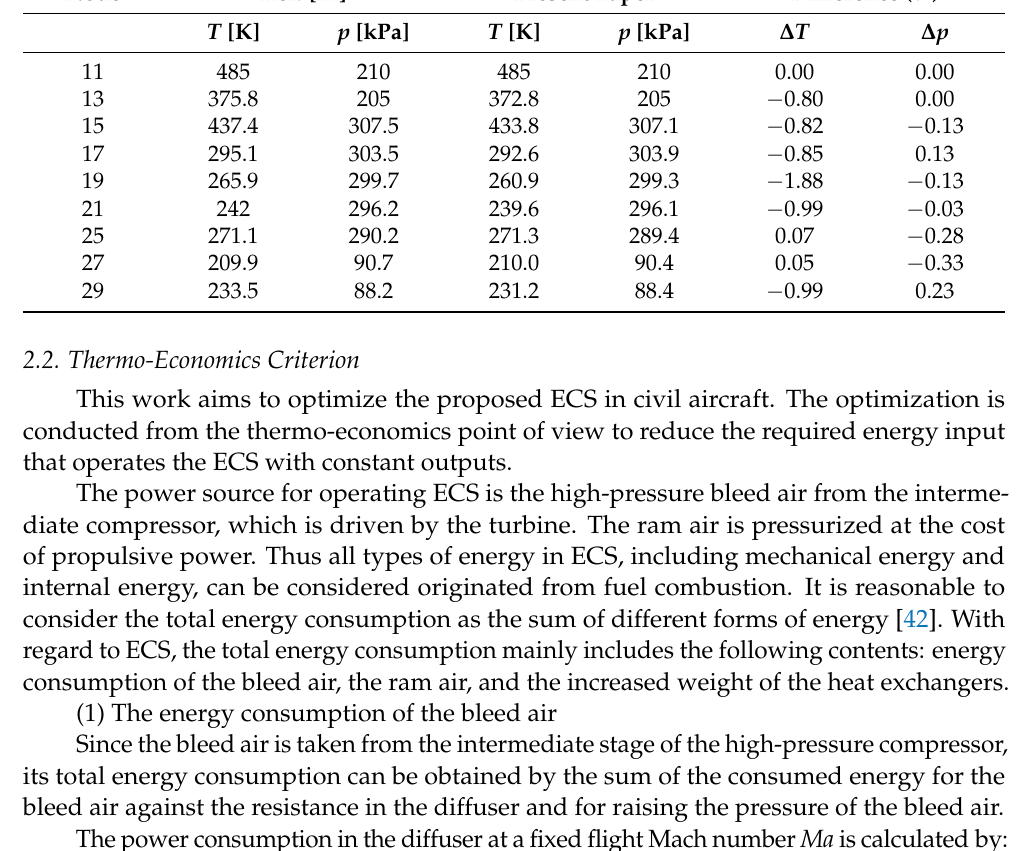
Table 1. Comparison between the results of the present paper and the corresponding results of Ref. [21]. Node Ref. [21] Present Paper Difference